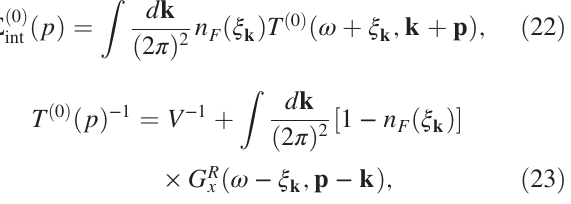
ϵ 2 m = 2 , m , and disorder broad- e ¼ T x ¼ e ϵ = 100 x ¼ T